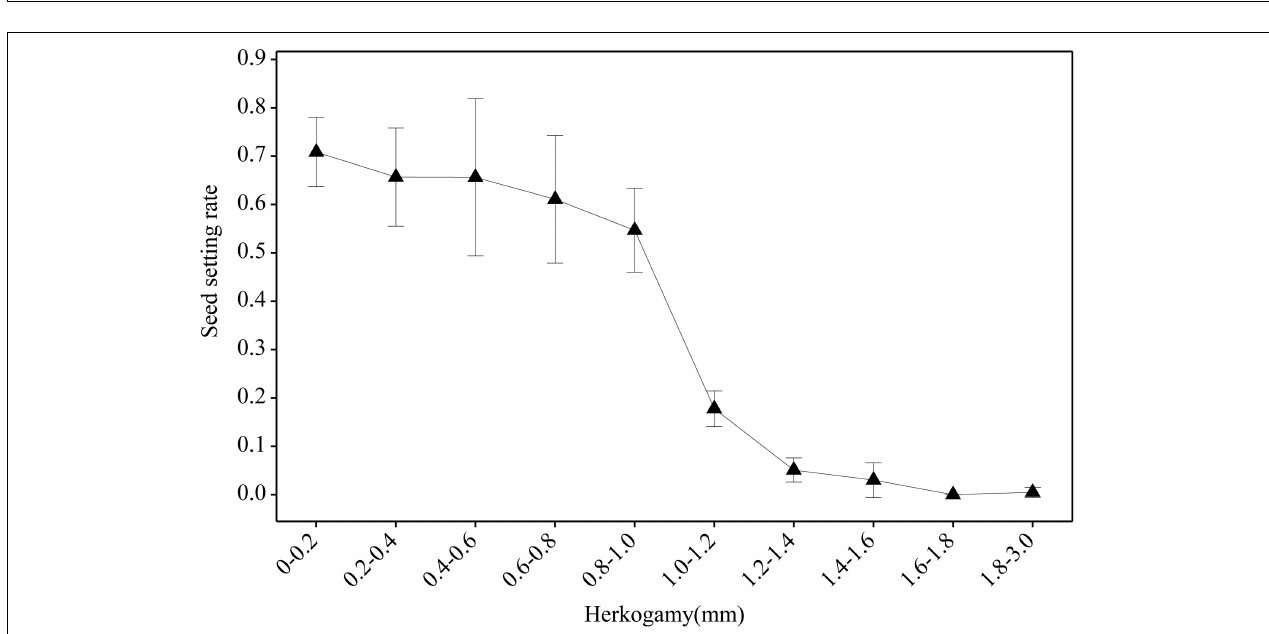
FIGURE 7 | Correlation between seed setting rate and herkogamy of P. wannanensis plants covered or without a net. Dotted lines indicate linear regression.